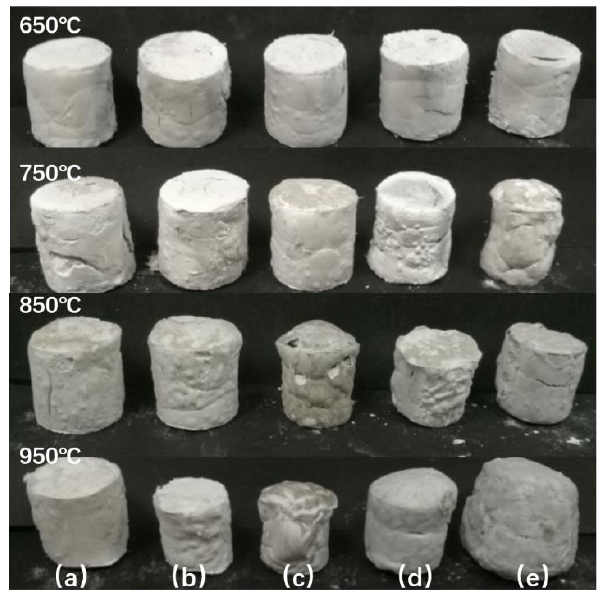
Figure 4. Macroscopic morphology of the residues at different temperatures of ( a ) SR, ( b ) SR/10Frits, ( c ) SR/20Frits, ( d ) SR/30Frits, and ( e ) SR/40Frits.